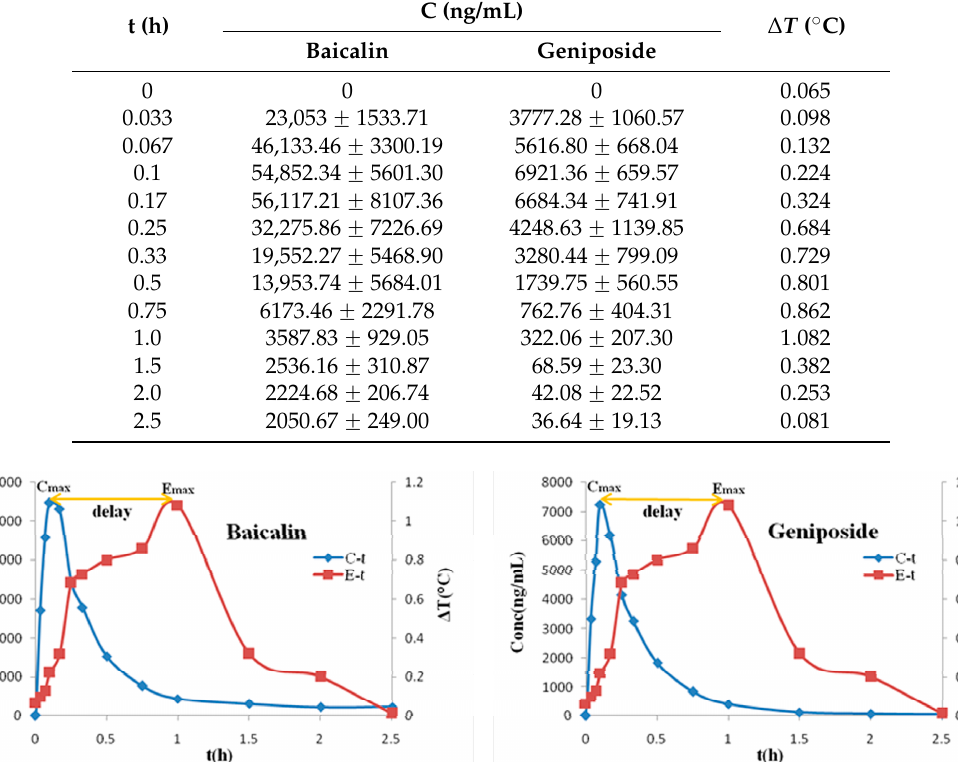
Table 2. The plasma concentration of baicalin and geniposide and the corresponding body temperature change of MTG rats during 2.5 h after QKLI administration.